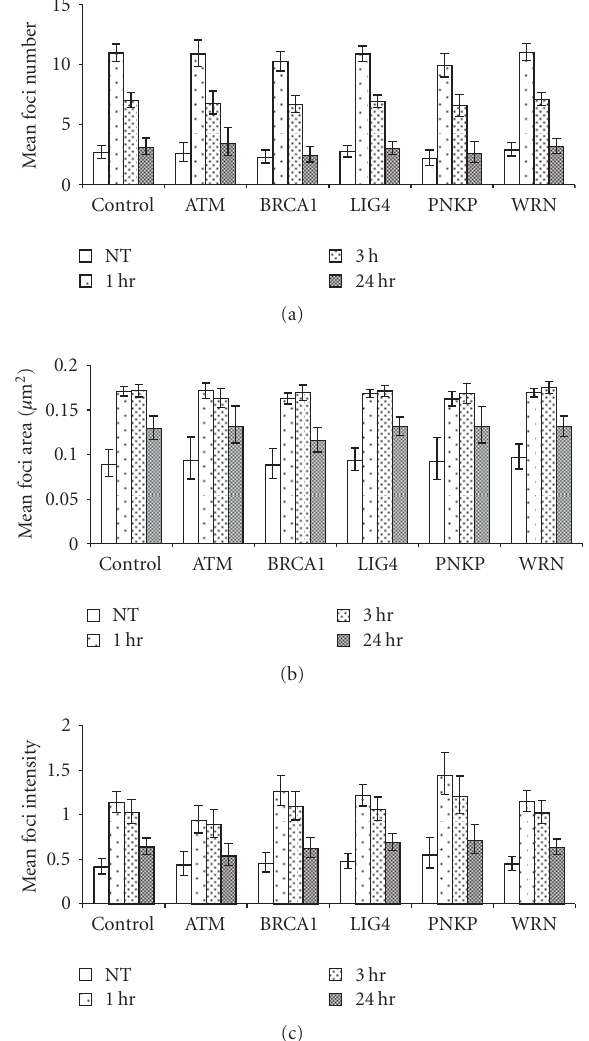
Figure 3: Summaries of gene-(nsSNP-)specific temporal response patterns following 1.5Gy gamma irradiation for three di ff erent response measures. Time points are NT/preexposure, 1 hour, 3 hours, and 24 hours following irradiation. Error bars represent 95% confidence limits. (a) Mean number of foci. (b) Mean area of foci. (c) Mean intensity of